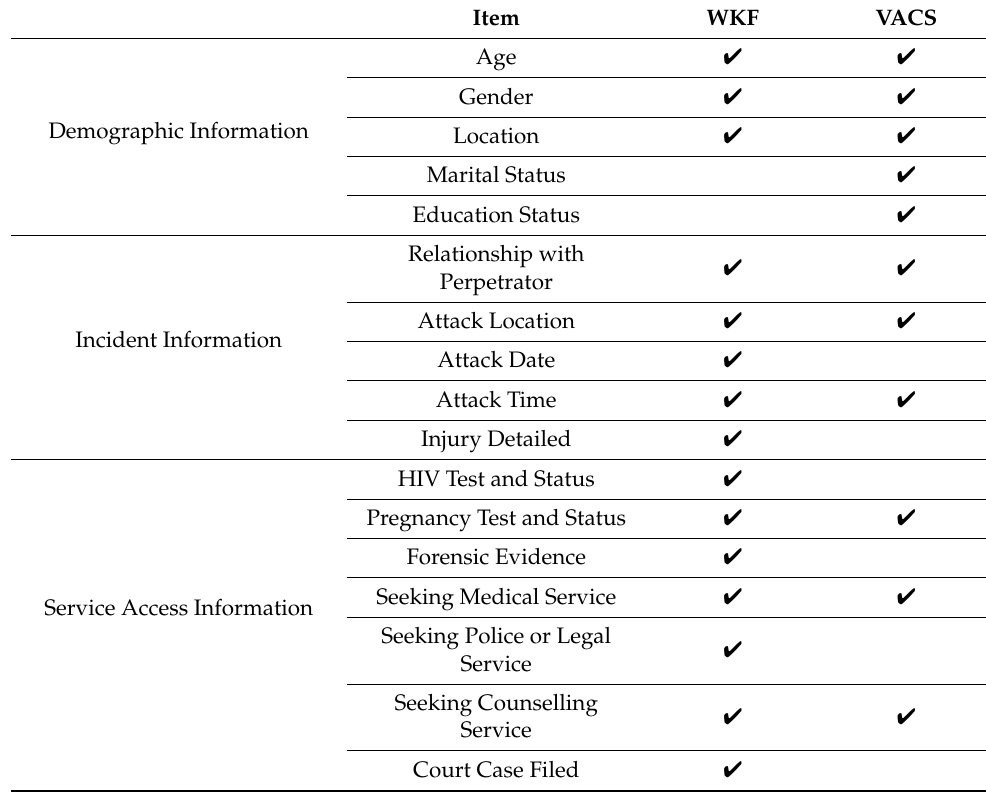
Table 1. Items collected by the WKF compared with the VACS